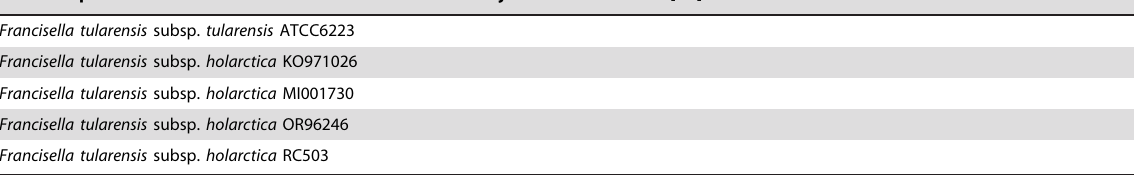
Figure S1 Whole genome sequence alignments and dotplot